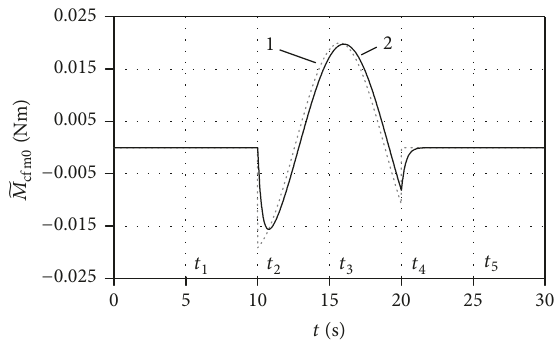
̃𝑀 value by proposed FI cfm 0